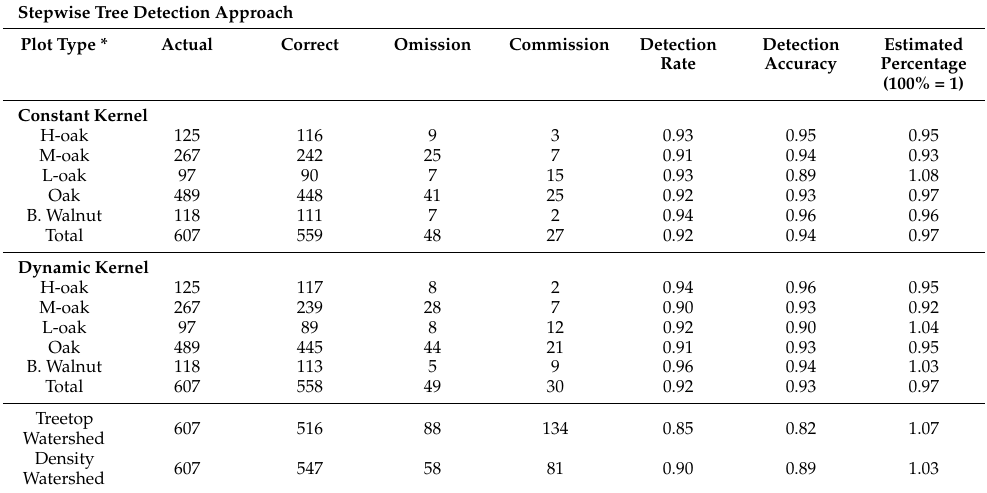
Table 3. Results of the stepwise tree detection approach (HMeanShift with either constant or dynamic kernel followed by vertical structure analysis).